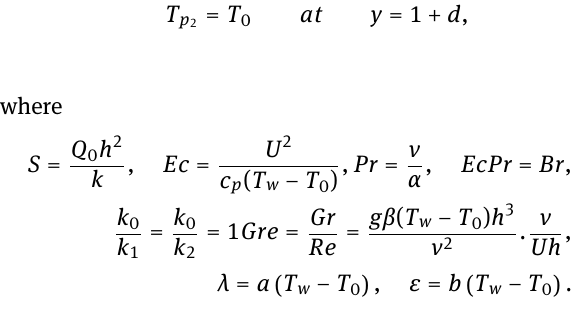
less eqn (10) are; heat generation/absorption, ( S ), viscous dissipation (Eckert number, Ec ), Prandtl number ( Pr ), Grashof number and Reynold number ( Gr ), viscosity and Re conductivity factor parameters ( λ ) and ( ε ) respectively. All other physical parameters are defined in